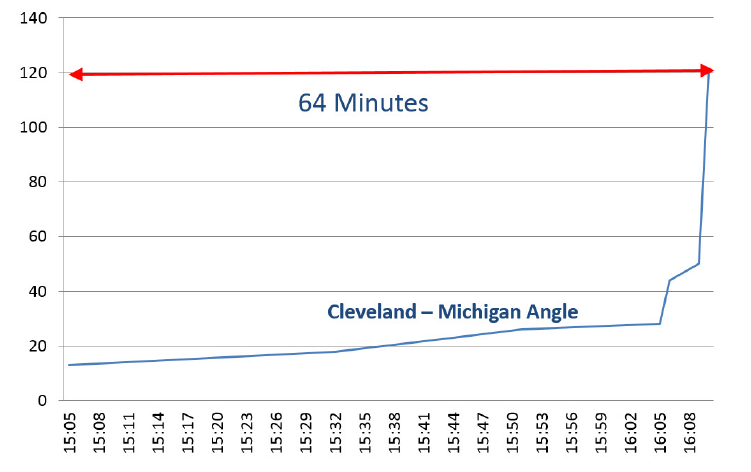
Figure 1. Phase angle divergence between Cleveland and